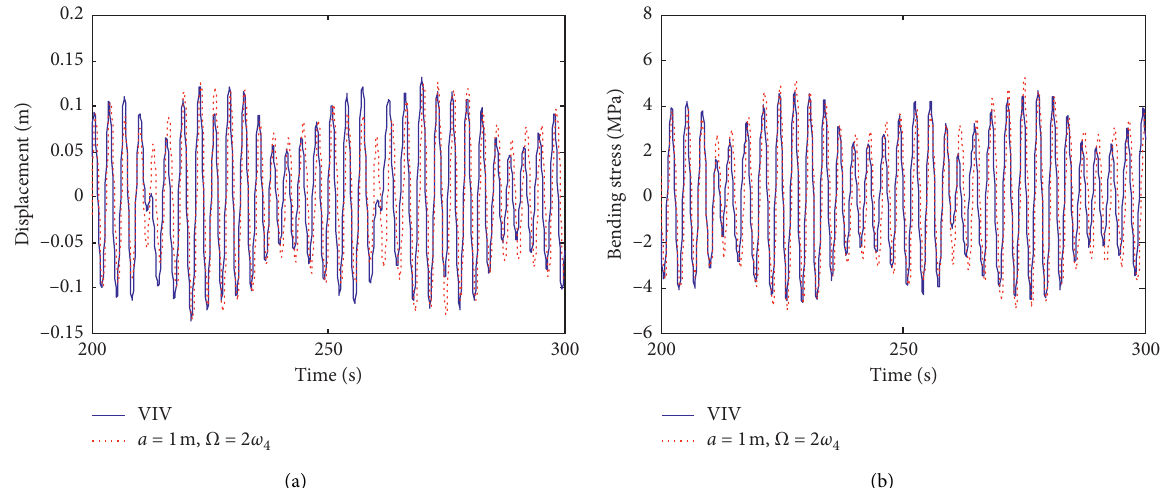
Figure 4: Dynamic response of TTR ( U � 0.5m/s and z � 1125m). (a) Time history of displacement. (b) Time history of bending stress. 0